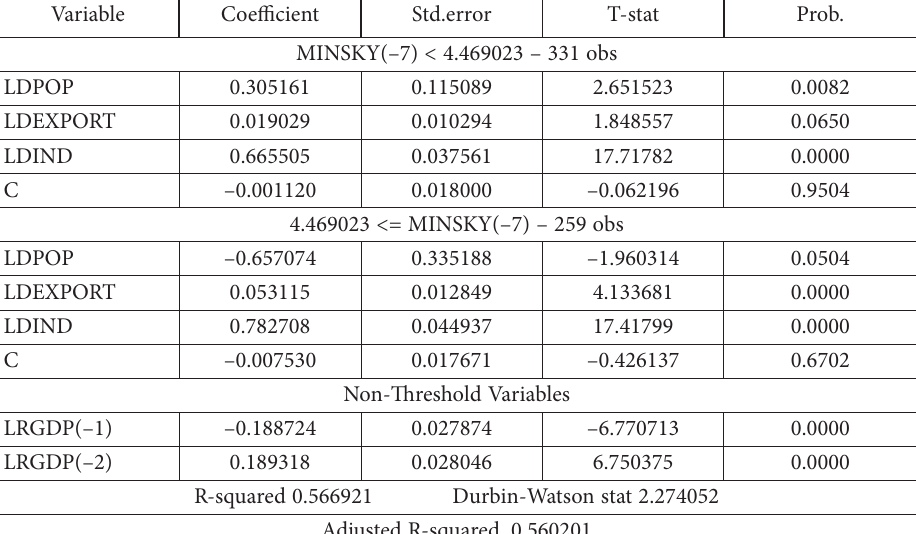
Table 3. Minsky discrete threshold regression model (source: authors’ calculation)